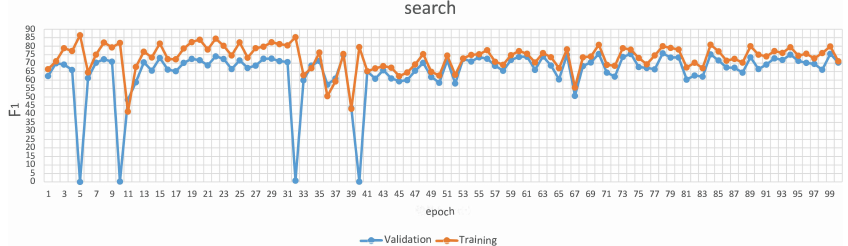
Figure 9. The effect of channel pruning on HRSID: pruning is triggered 4 times. After that, overfitting (the gap between two curves) is restrained.